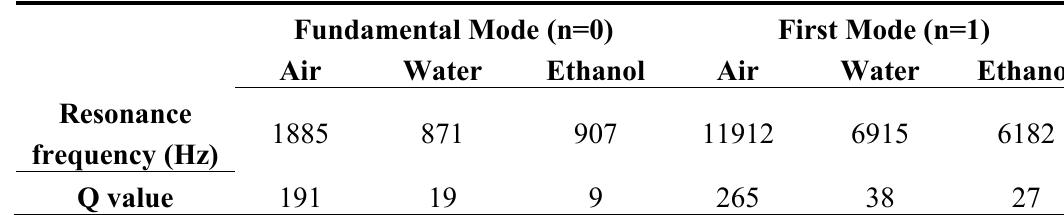
Table 1 . Resonance characteristics of an MSMC in